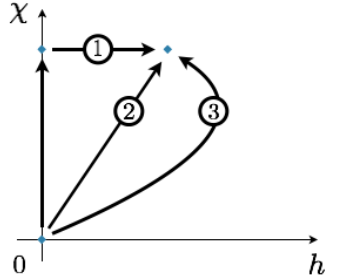
Figure 1 . Sketch of di(cid:11)erent trajectories for the phase transition in composite Higgs models. The (cid:12)eld (cid:31) sets the size of the strong-sector condensate and h is the Higgs vev. The blue points correspond to (meta)stable vacua of the theory, and the black lines show possible phase transition